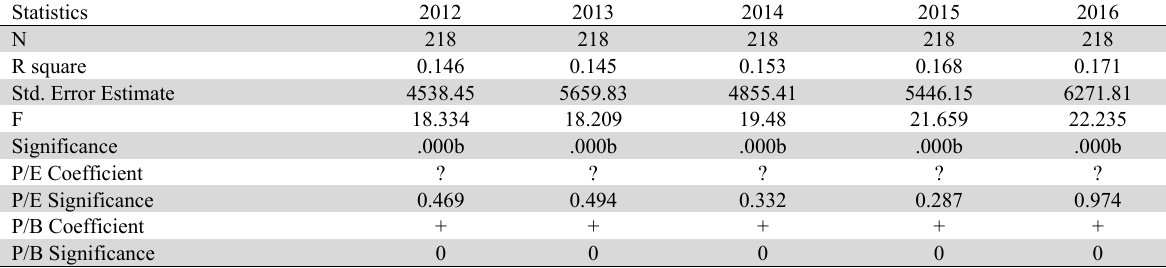
Statistical Analyses Result of Year 2012-2016